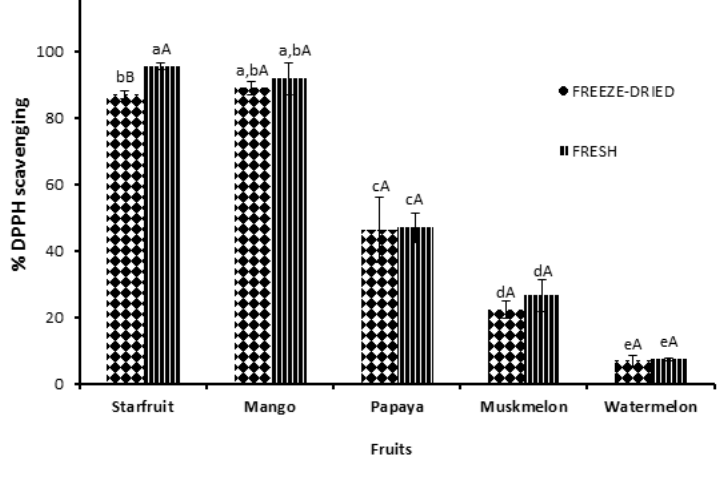
Figure 1. DPPH (2,2-diphenyl-1-picrylhydrazyl) radical scavenging activity of fresh and freeze-dried fruits. Data expressed as % inhibition at 5 mg/mL. Values denoted with the same small letter are not significantly ( p > 0.05) different among fruits tested. Values with the same capital letter are not significantly ( p > 0.05) different between the fresh and freeze-dried fruits. Data stand as means of three